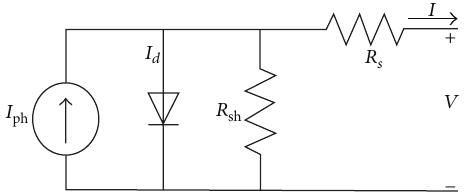
Figure 2: PV circuit model with series and parallel resistances, 𝑅 𝑠 and 𝑅 𝑝